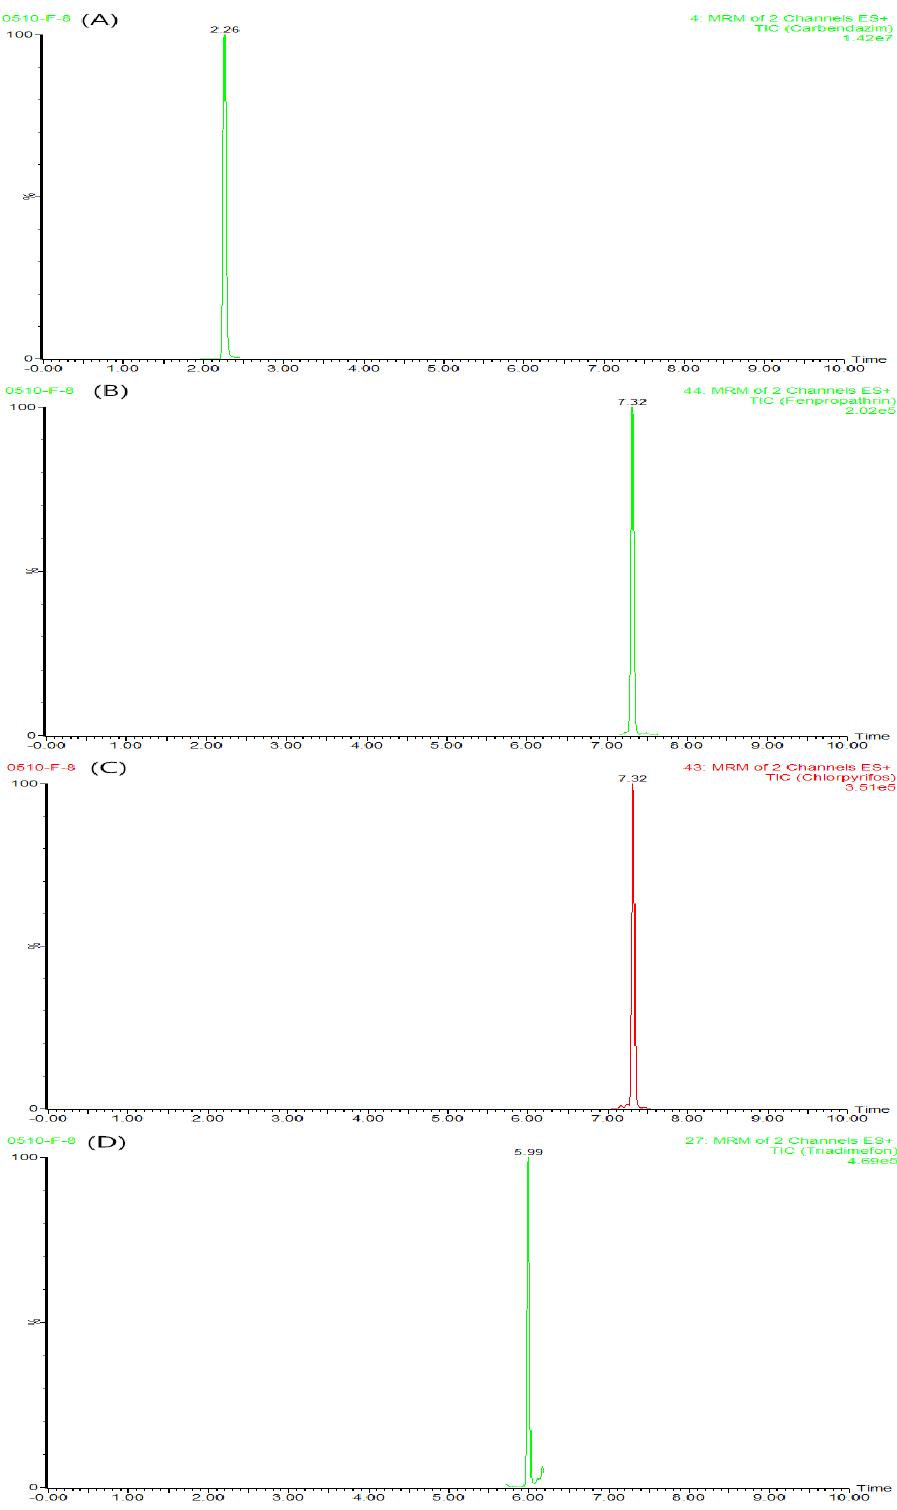
Figure 1. An example of the extracted multiple reaction monitoring mode (MRM)1 chromatograms of a pollen sample, indicating the presence of ( A ) carbendazim; ( B ) fenpropathrin; ( C ) chlorpyrifos; and ( D ) triadimefon.